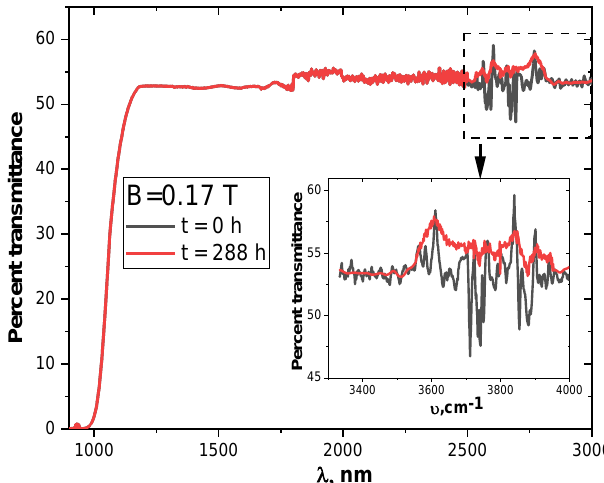
Figure 7. Infrared transmittance spectra of the initial p-Si samples before and after 288 h of exposure to the magnetic field.